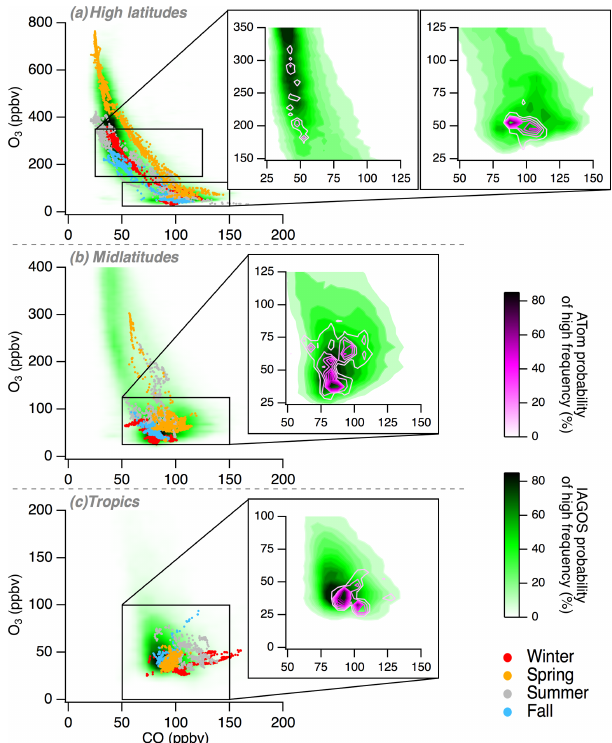
Figure 8. IAGOS and ATom seasonal O 3 vs. CO scatterplots, with insets showing the most frequent O 3 values measured during IA- GOS and ATom. ATom seasonal deployments are colored accord- ing to the legend. The frequency gradient of the O 3 counts is illus- trated by the color scales (green for IAGOS and magenta for ATom). ATom measurements have been combined for the frequency gradi- ents shown in the insets. The probability of high frequency refers to the probability of finding frequently measured O 3 values within the contour